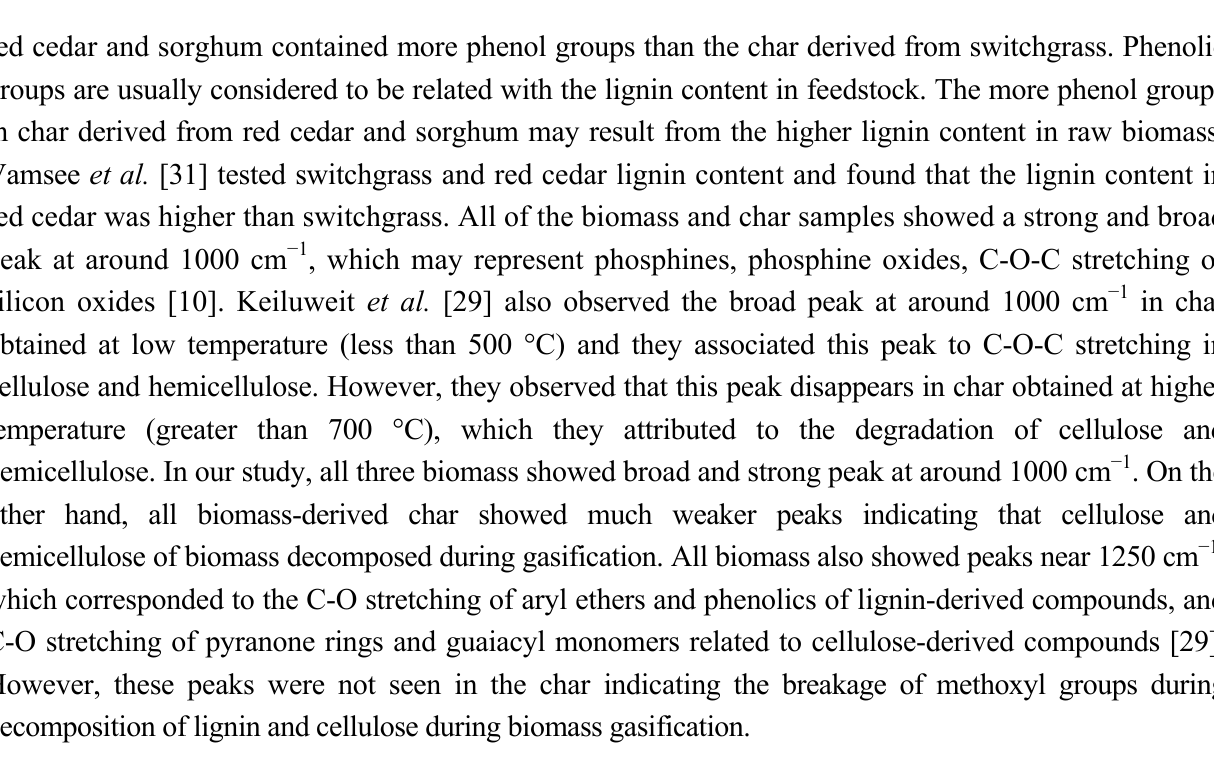
Figure 4. FT-IR spectra of raw biomass and char obtained at equivalent ratios of 0.25 and